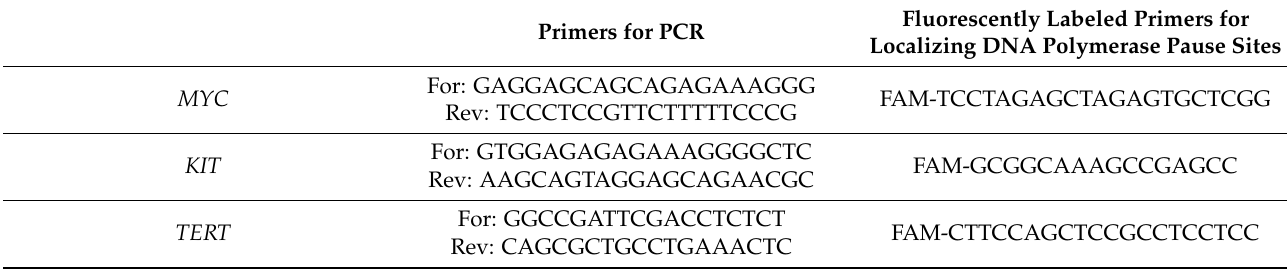
Table 2. Primers and oligonucleotides used for analysis. Fluorescently Labeled Primers for Primers for PCR Localizing DNA Polymerase Pause